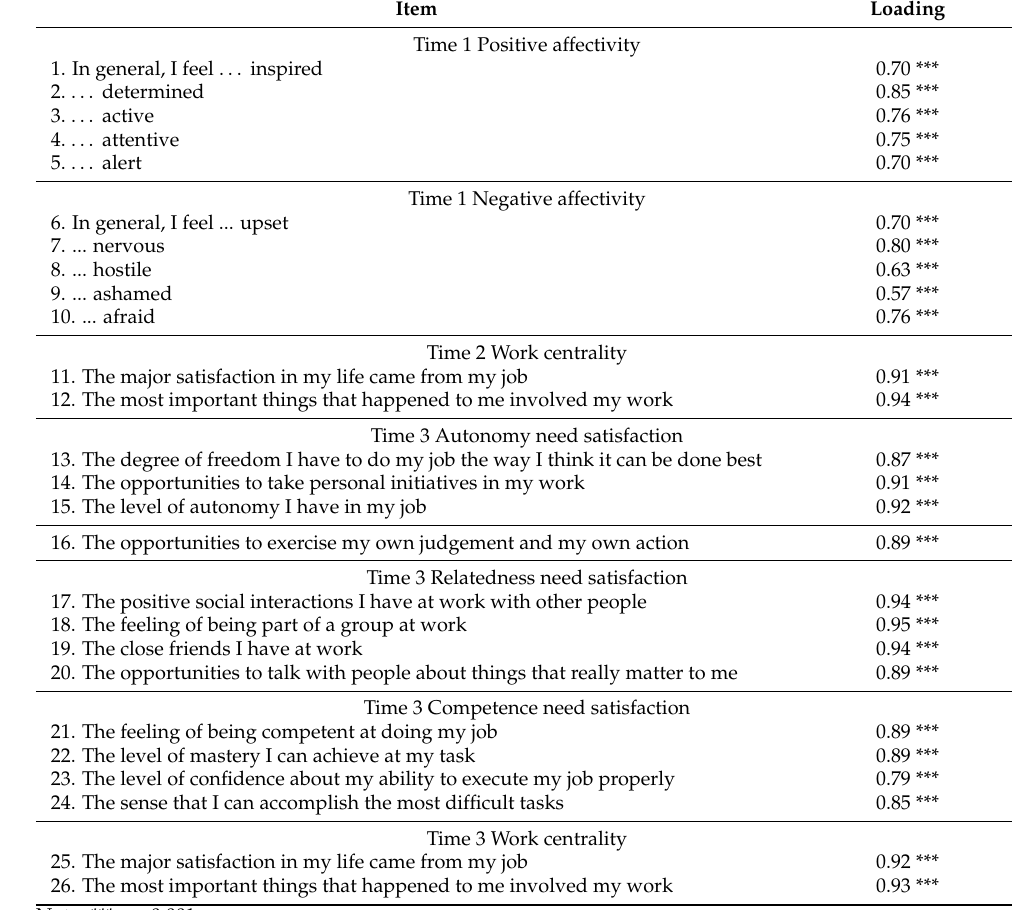
Table 2. Completely Standardized Confirmatory Factor Analysis Loadings for Scale